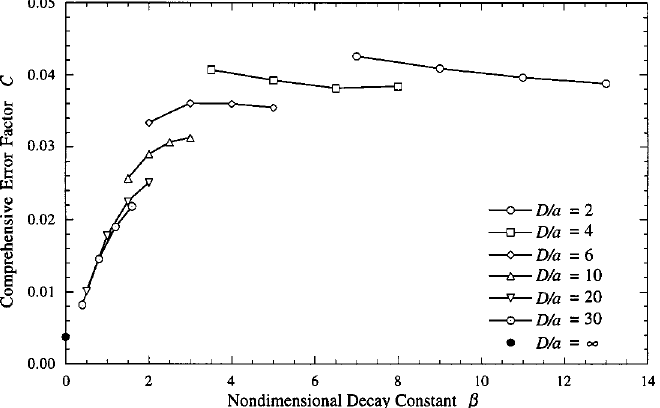
Fig. 2. Comprehensive error factors for radial-velocity histories at (cid:18) = (cid:25) calculated by modal summation ( N = 4 vs N = 7); empty spherical shell excited by various spherical step-exponential waves.